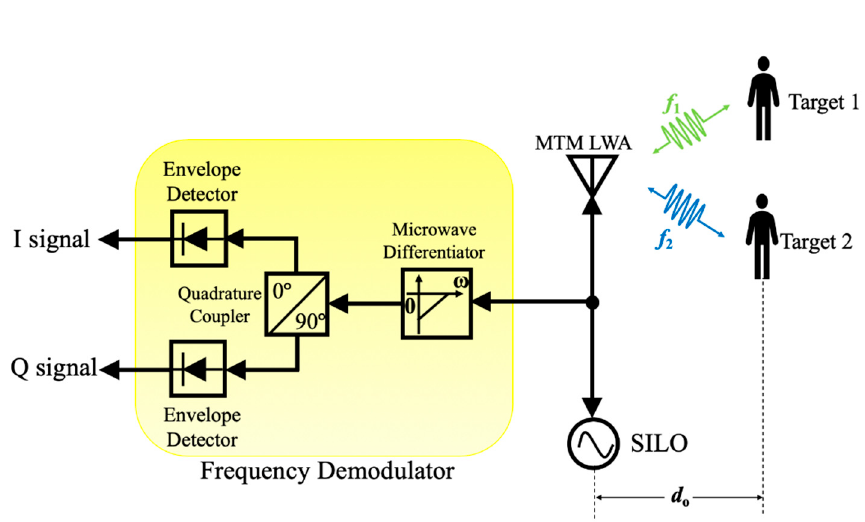
Figure 13. The block diagram of proposed MTM LWA based on self-injection-locked (SIL) radar sensor architecture, illuminating two distinct operation frequencies to two targets.